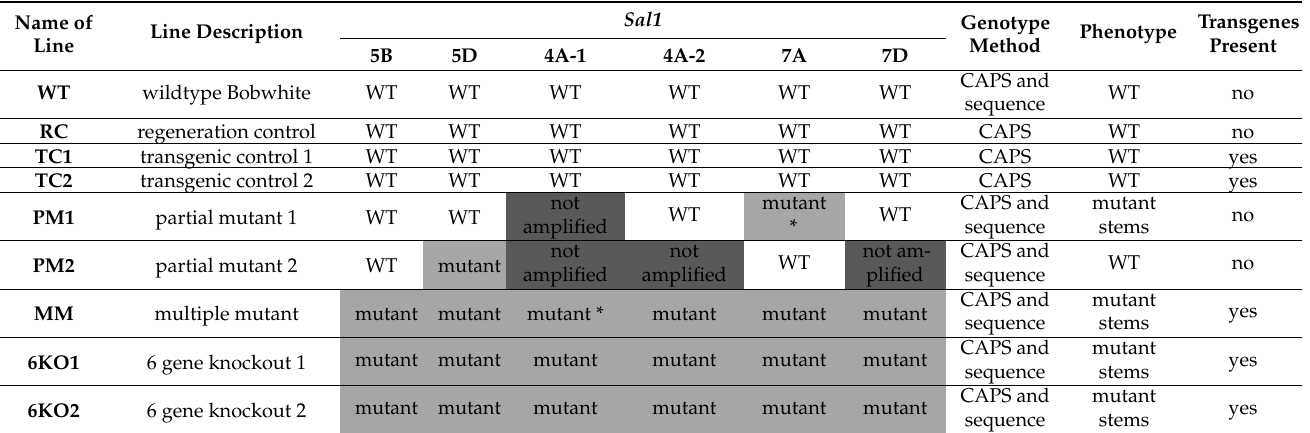
Table 2. Genotypes and phenotypes of the wheat lines used in